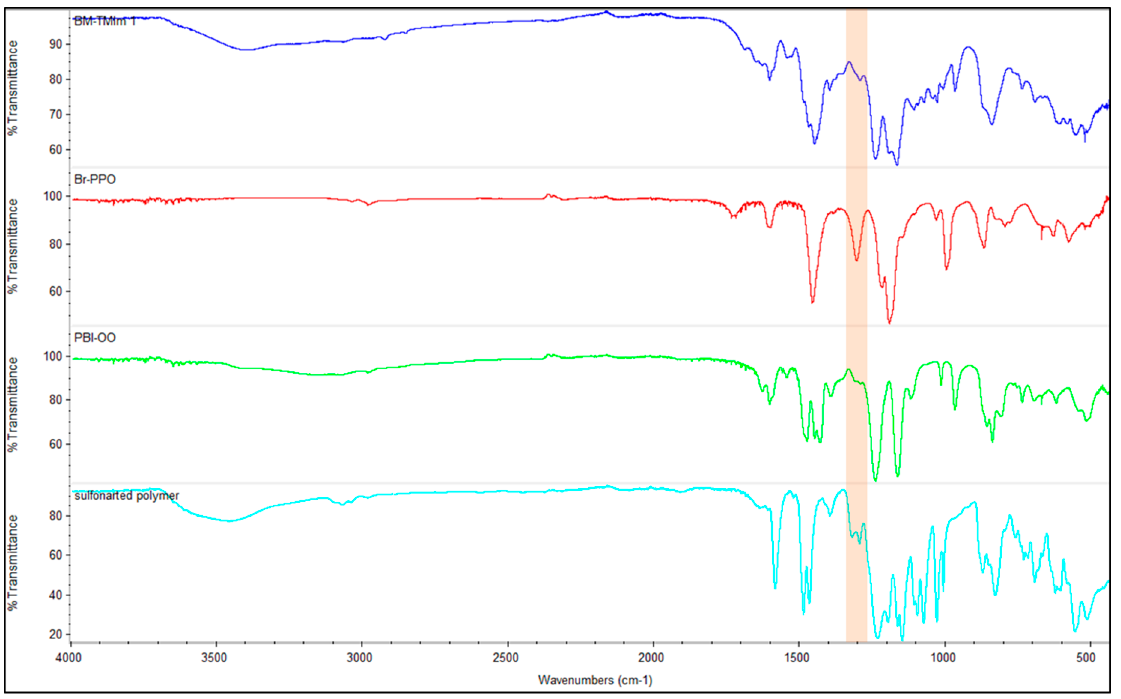
Figure 4. Fourier-Transform Infrared (FT-IR) spectrum of blend-forming polymers and of one